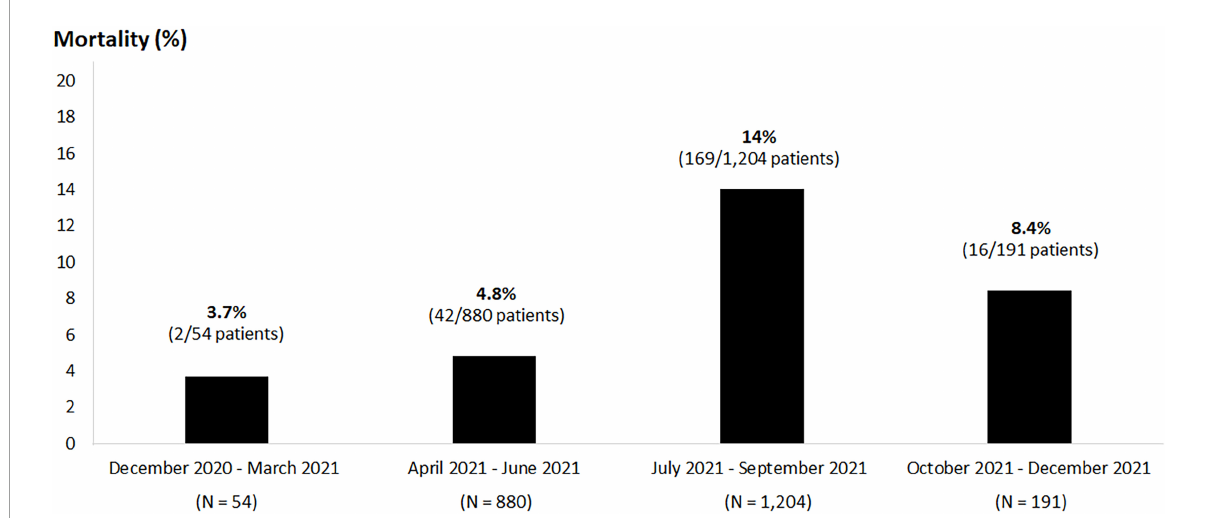
FIGURE2 Trends in mortality from December 2020 to December 2021. Most cases ( n = 2,329) were admitted from December 2020 to December 2021. The mortality rates changed over time; the highest mortality (14%) occurred at the same time as the highest admission rate (1,204 hospitalized patients) in July–September 2021. Only 101 patients were admitted between January and April 2020; no mortality was observed in that period, and no COVID-19 patient was hospitalized from May to November 2020.